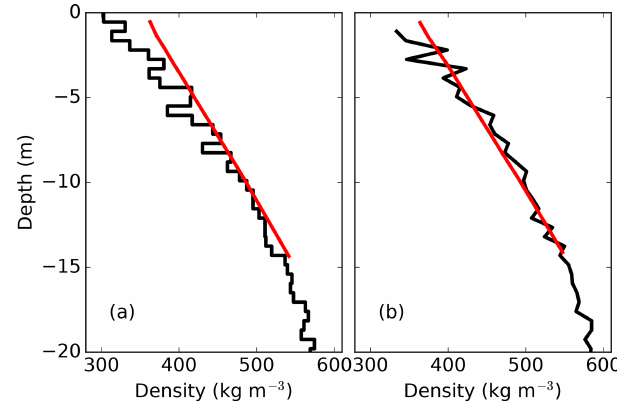
Figure 10. Modelled firn densities (BEST T ) at NGRIP (a) and NEEM (b) in red. Firn measurements of Schwander (2001) and Schwander et al. (2008) in